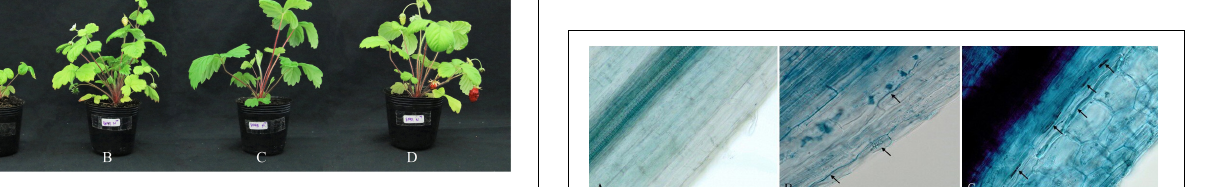
FIGURE 6 | Melanized fungal hyphae formed by DSE fungi in strawberry roots. (A) Non-treated DSE as control roots. (B) Exophiala sp. SK47-treated roots. (C) C. chaetospira SK51-treated roots. Bars: 50 µ m (A) , 20 µ m (B–C)